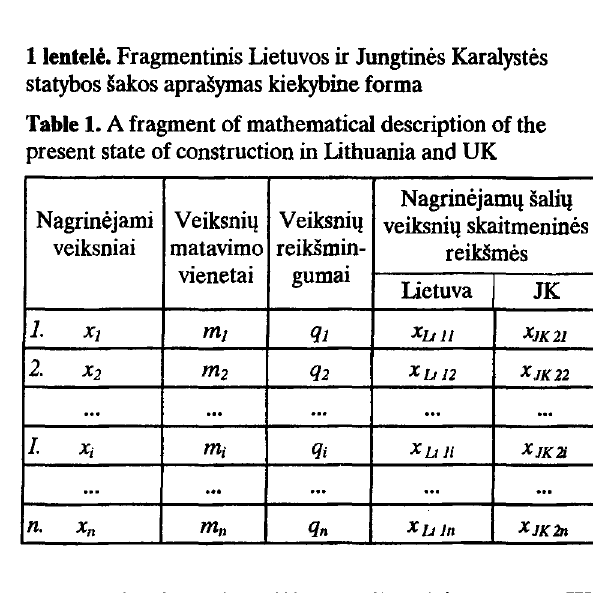
Table 1. A fragment of mathematical description of the present state of construction in Lithuania and UK Nagrinejamq saliq Nagrinejami Veiksniq Veiksniq veiksniq skaitmenines veiksniai matavimo reikSmin- reikSmes vienetai gumai